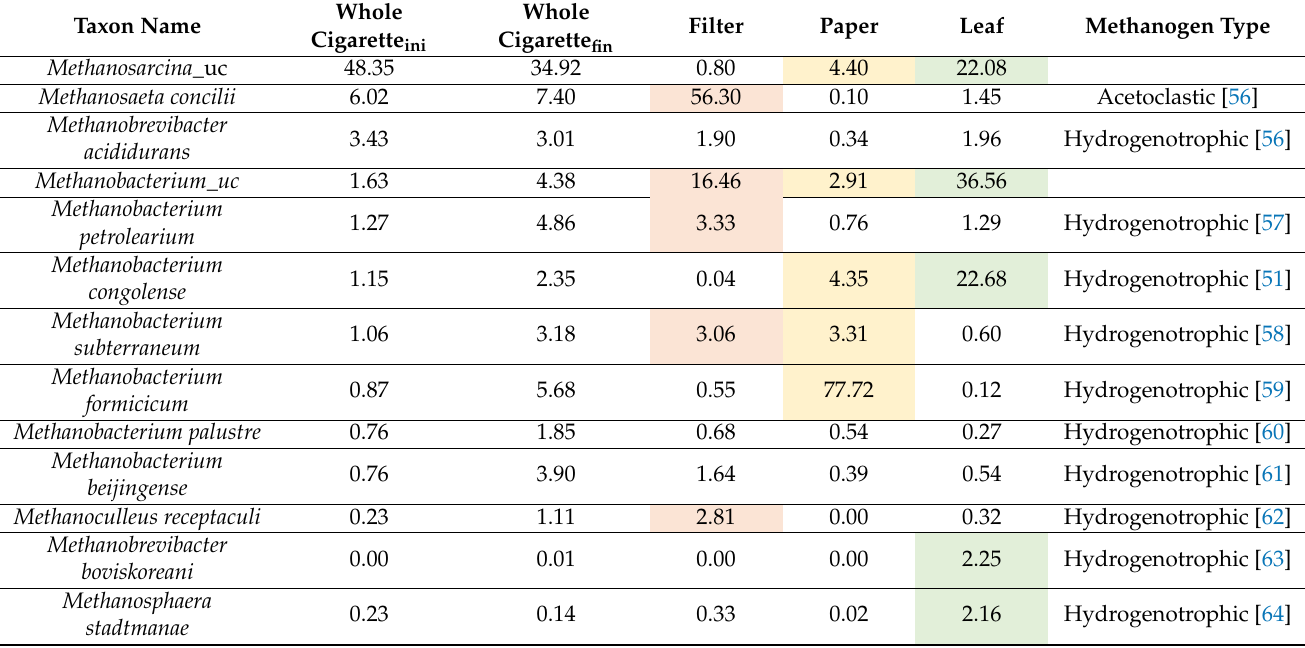
Figure 5. Methanogen distribution at the species level in anaerobic digestion reactor fed intact cigarettes or individual components. Table 3. Methanogens in an AD reactor fed cigarette butts or individual